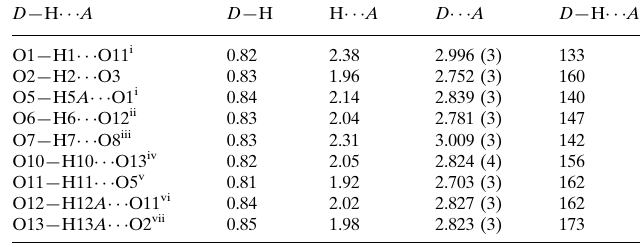
(cid:1) CH The title compound, C H O O, was prepared by 41 70 12 4 microbial transformation. Within the steroid skeleton of the molecule, three six-membered rings exhibit a chair conforma- tion, while the five -membered ring adopts an envelope conformation. The two pyranosyl rings also adopt chair conformations. The molecules are held together by an